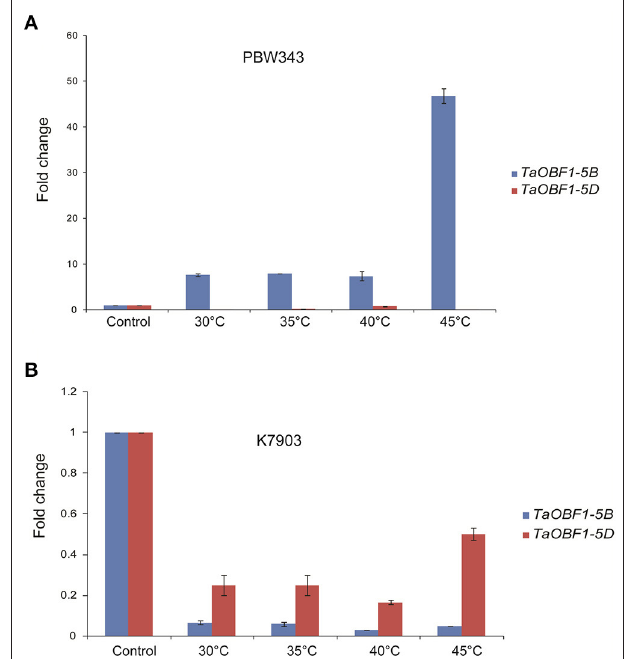
FIGURE 2 | Expression analysis of TaOBF1 homoeologs under heat stress conditions in Triticum aestivum cv. (A) PBW343 (heat sensitive) (B) K7903 (heat tolerant) seedlings at various temperatures. Relative fold change was checked by qRT-PCR. TaGAPDH was used as an internal control gene. Error bars indicate values ±